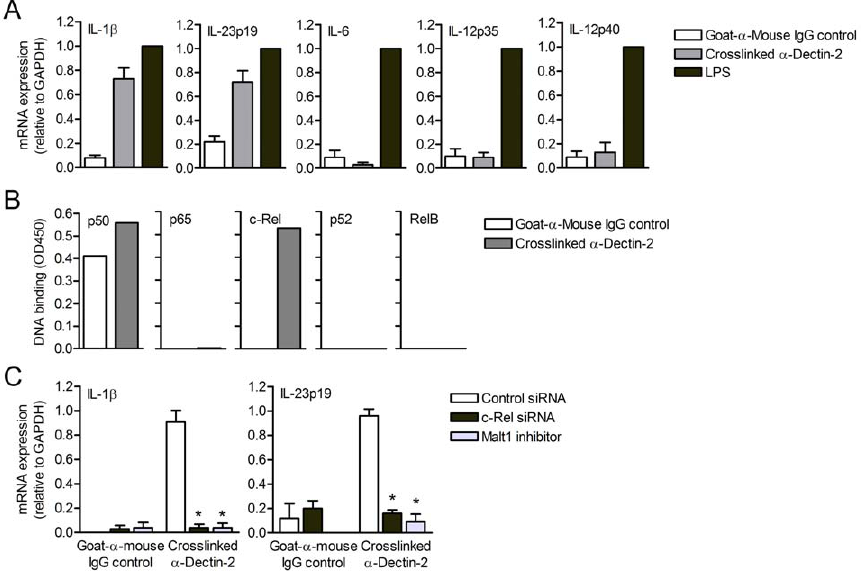
Figure 6. Dectin-2 signaling induces Malt1- and c-Rel-dependent IL-1 b and IL-23p19 expression. (A) Quantitative real-time PCR for indicated mRNAs in DCs stimulated with crosslinked dectin-2 antibodies or LPS. In (A–C), goat-anti-mouse IgG was coated as a control for aspecific activation. Expression is normalized to GAPDH and set at 1 in LPS-stimulated cells. Data are mean 6 s.d. of at least four independent experiments. (B) DNA binding of NF- k B subunits in nuclear extracts of dectin-2-triggered DCs. Data are representative of two independent experiments. (C) Quantitative real-time PCR for indicated mRNAs in DCs stimulated with crosslinked dectin-2 antibodies after c-Rel silencing or Malt1 inhibition with paracaspase inhibitor z-VRPR-FMK. Goat-anti-mouse IgG was coated as a control for non-specific activation. Expression is normalized to GAPDH and set at 1 in LPS-stimulated cells. Data are mean 6 s.d. of two independent experiments, * p , 0.05 (Student’s t -test).